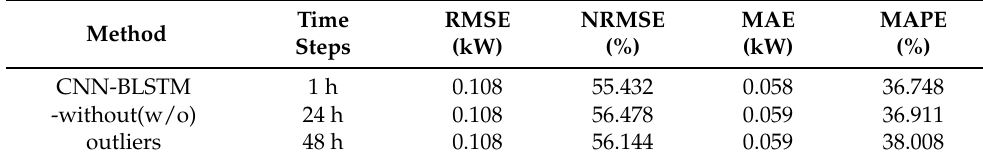
Table 7. Forecasting results of proposed method with different time steps.